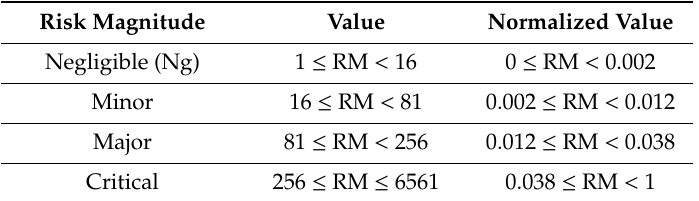
Table 6. Output Linguistic